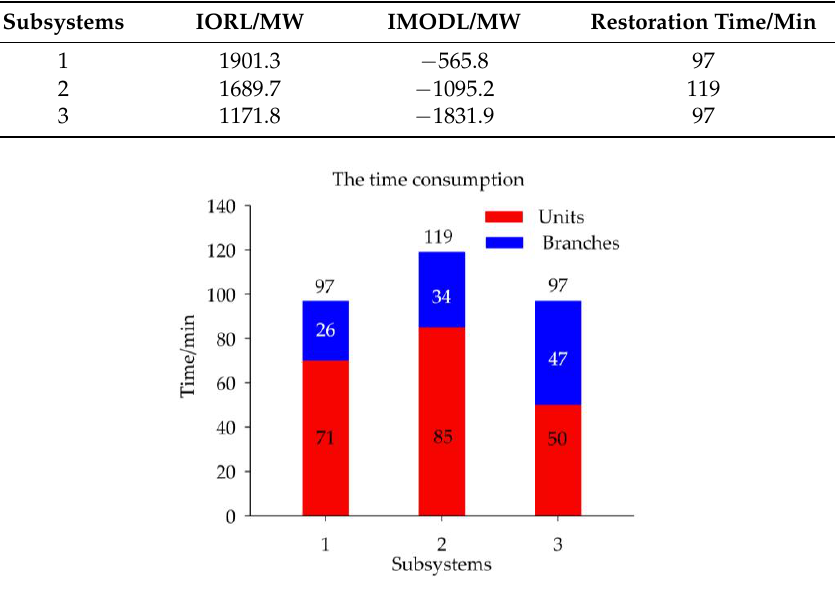
Figure 6. The optimal sectionalizing scheme of IEEE 39-bus test system.